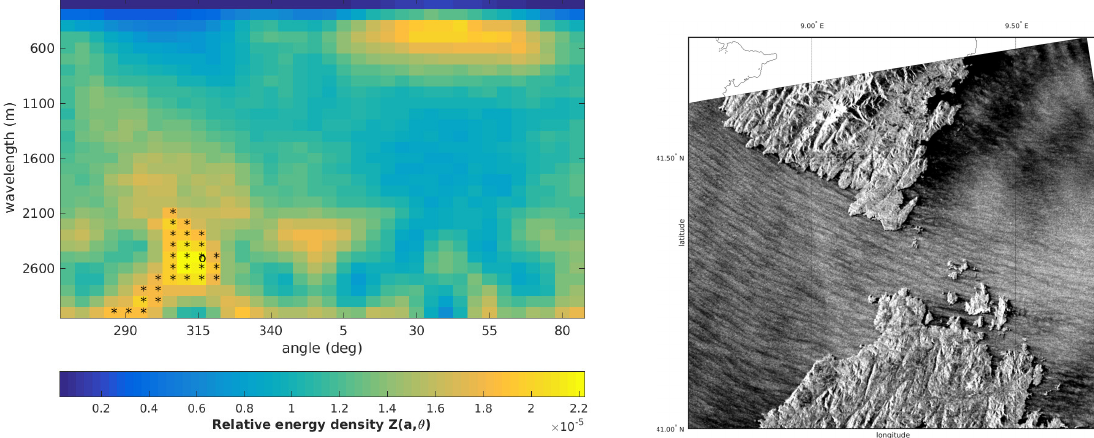
Figure 3. The relative scale-angle energy density spectrum Z ( a , θ ) ( left panel ) derived from the Sentinel-1A SAR image of the 3 February 2016 (S1A_IW_GRDH_1SDV_20160203T172129_20160203T1 72154_009785_00E4F4_AE4D) ( right panel ) of the Bonifacio Strait (see Figure 1). Z ( a , θ ) has been plotted as a function of the angles expressed in degree respect to the geographic north (abscissae) and the scales in meters (ordinates) used in the Two-Dimensional Continuous Wavelet Transform analysis. In the left panel, the stars indicate the scales and angles selected for the image reconstruction and the circle the spectrum maximum